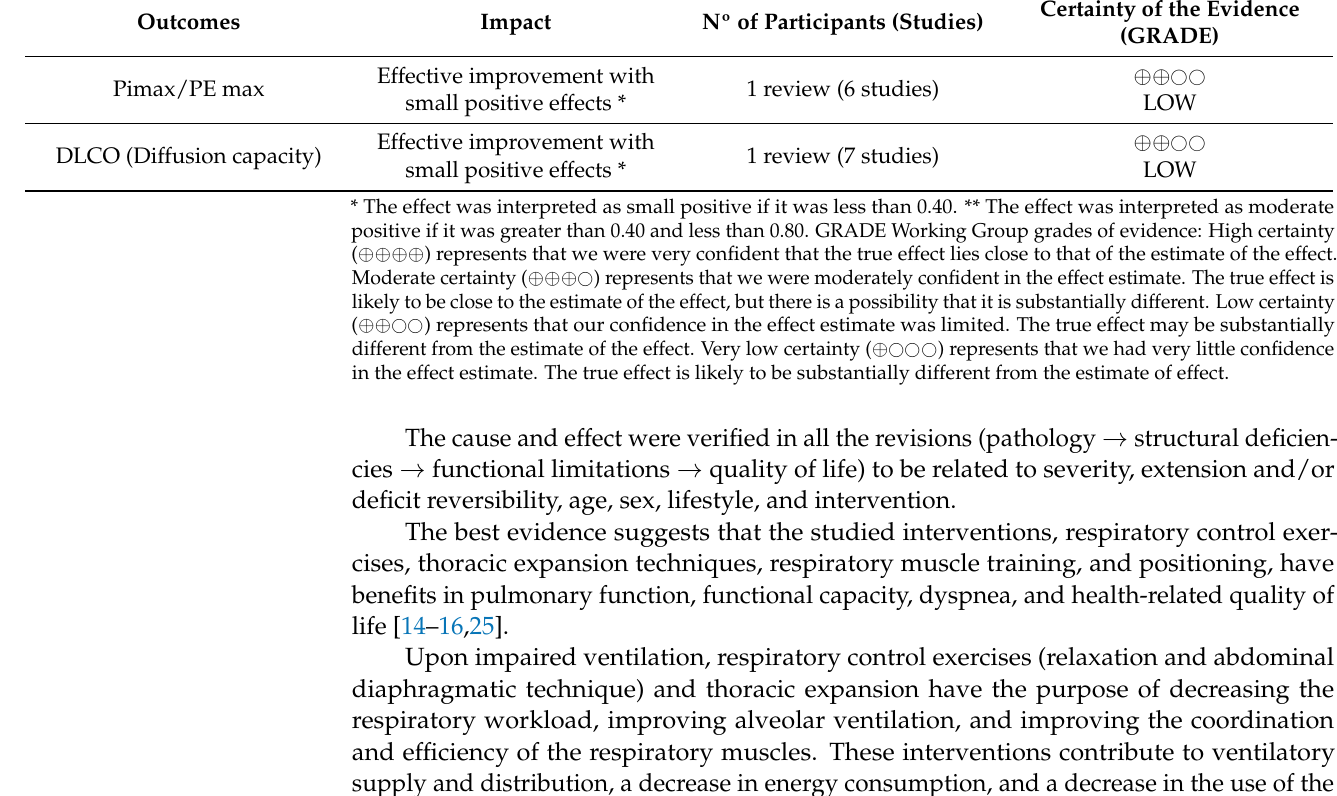
Table 5. Cont. Outcomes Impact Nº of Participants (Studies) Effective improvement with Pimax/PE max DLCO (Diffusion